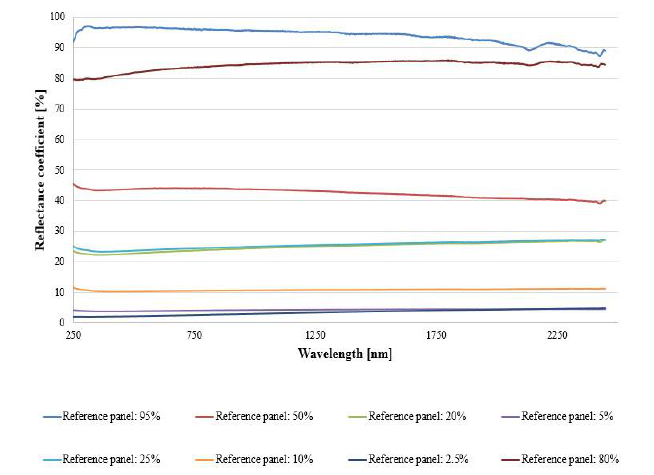
Figure 6. DN values for reference panels on the raw hyperspectral